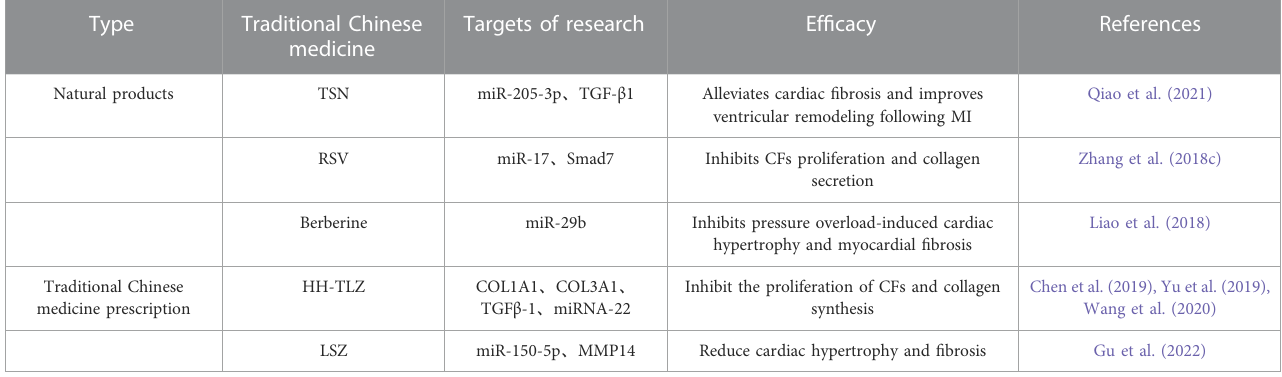
TABLE 7 Mechanism of TCM against myocardial fi brosis by targeting TGF- β /Smad signaling pathway and ncRNAs.